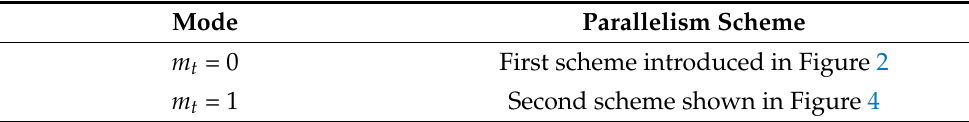
Table 1. Supported parallelism schemes based on m t of the proposed BNN accelerator.